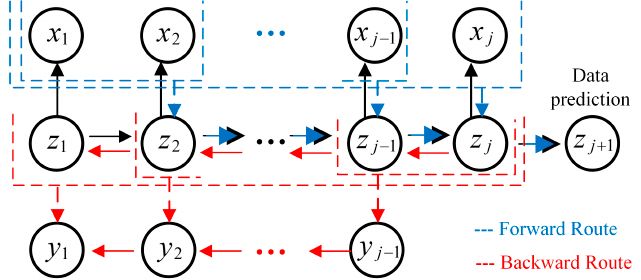
Figure 4. The tree structure interconnecting observed variables and latent variables through forward ( blue line ) and backward (red line ) routes.